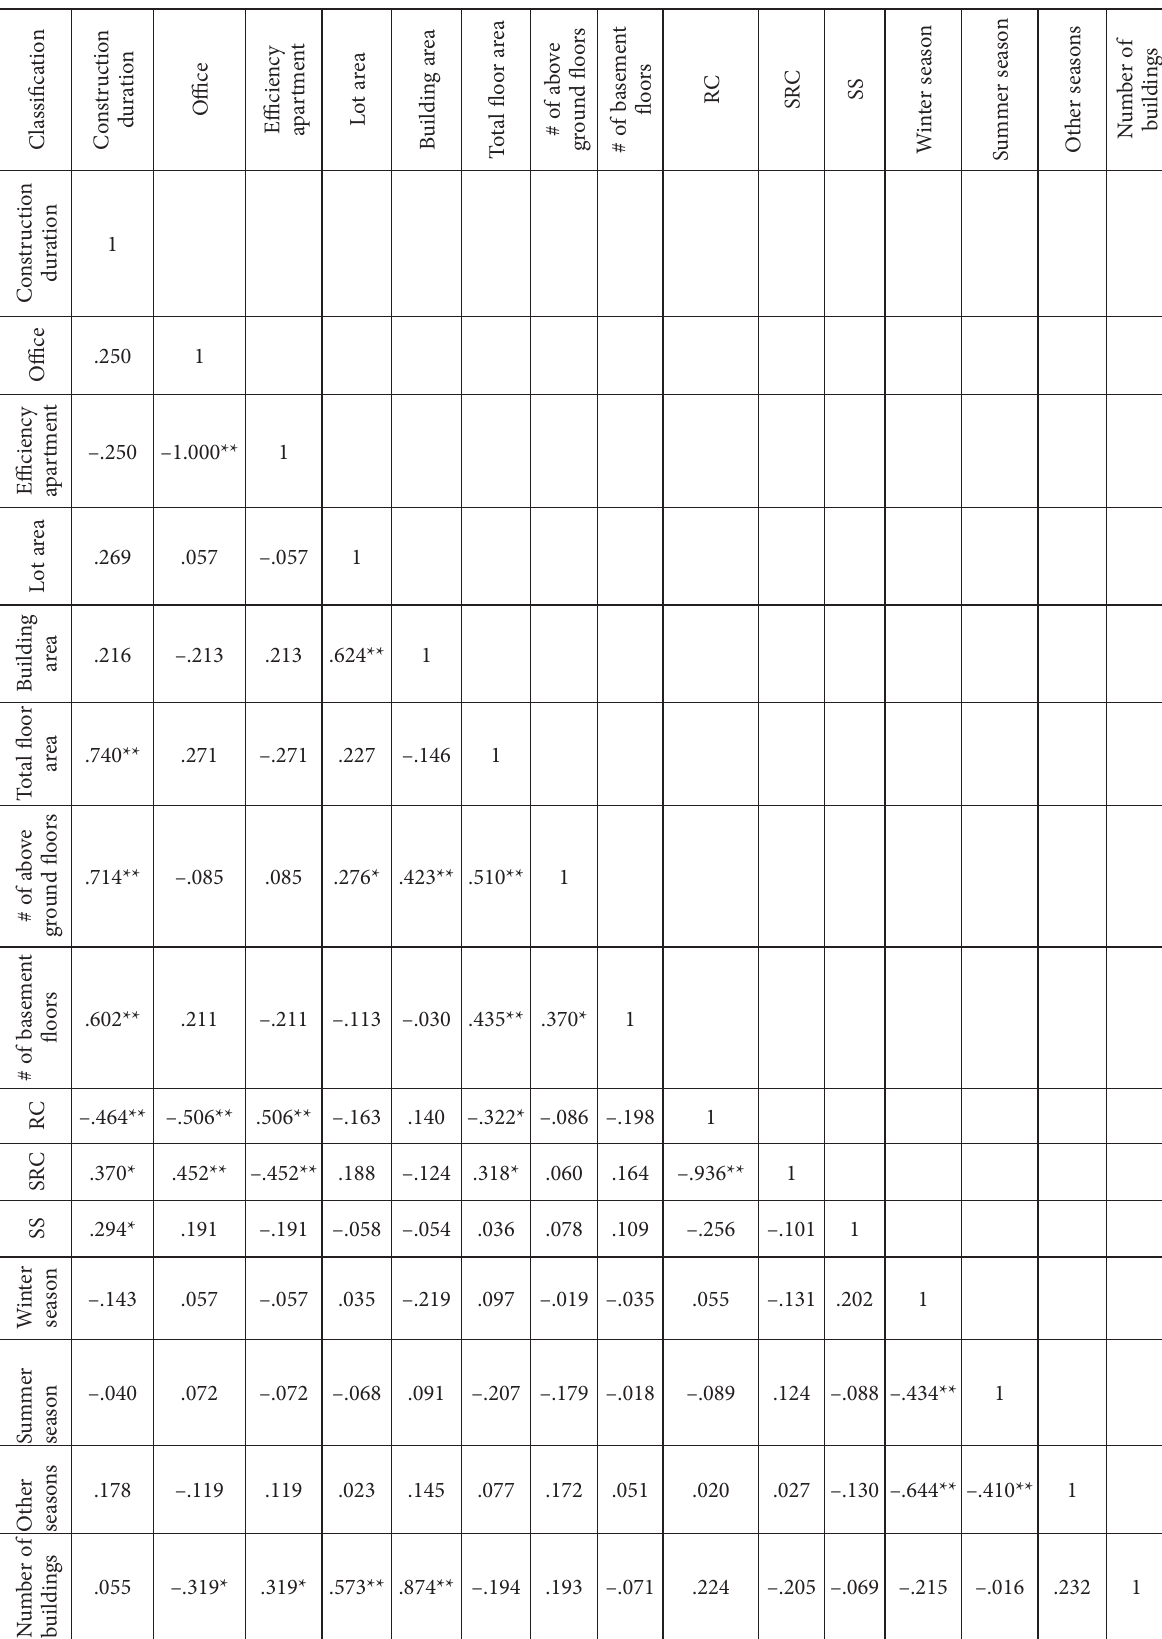
Table 5. Results of correlation analysis – Pearson correlation